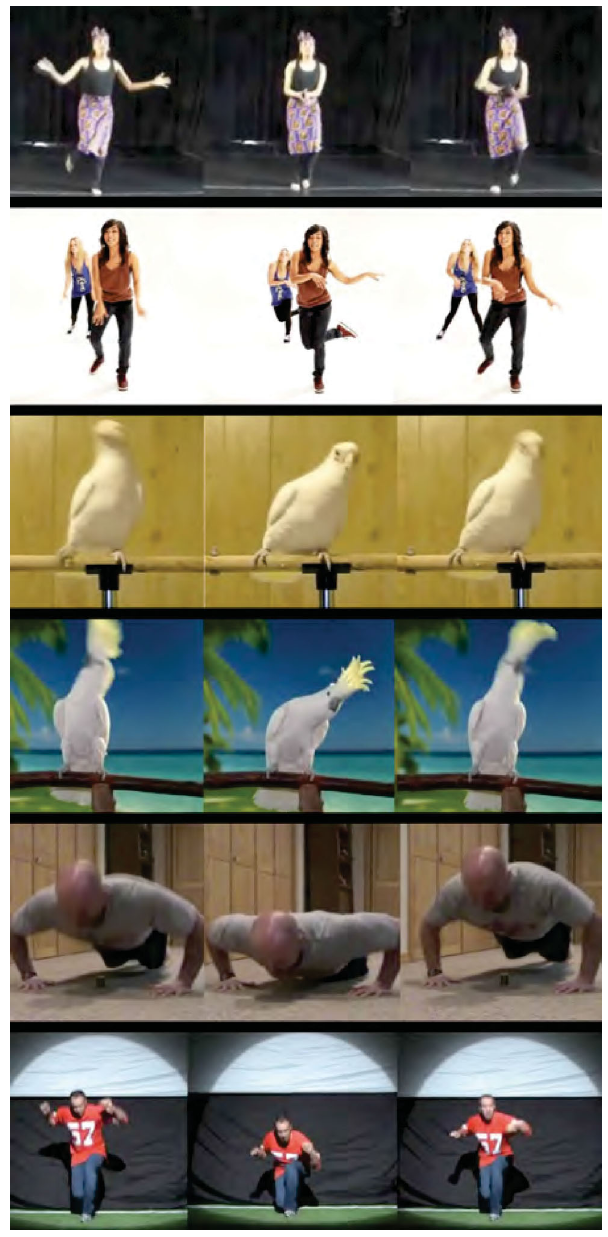
Fig. 6 Typical frames from each input video; the center frame shown for each video occurs at a motion beat. Note that we can handle videos with a moving camera (such as the first video) and significant motion blur (such as the parrot